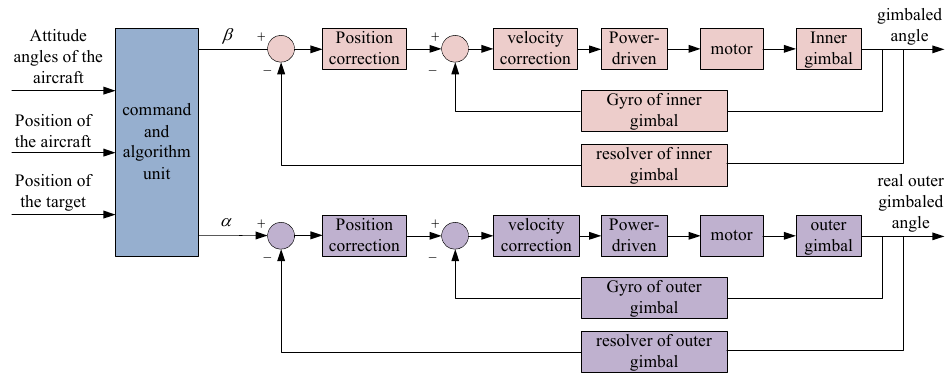
Figure 5. Block diagram of gimbaled control.